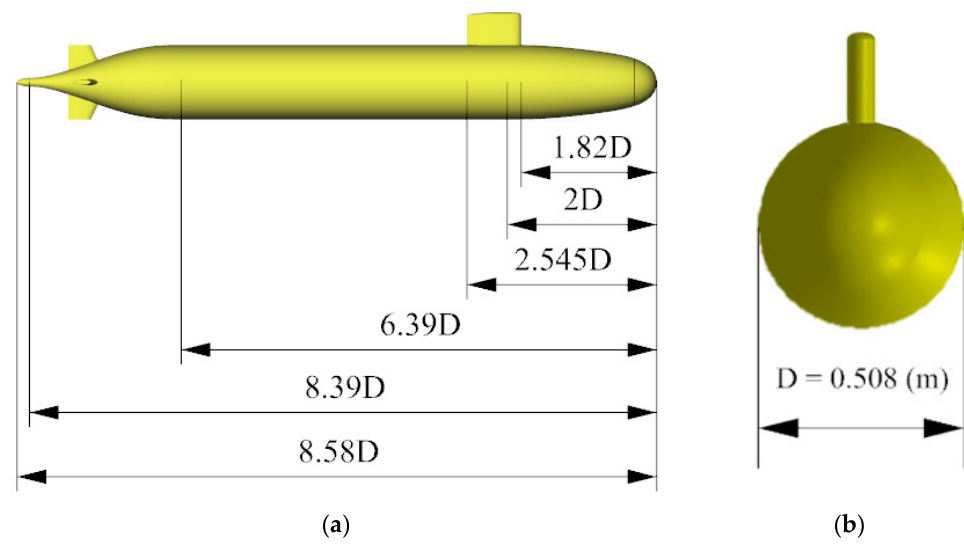
Figure 1. Schematic diagrams of SUBOFF model with full appendages at ( a ) side view, and ( b ) front view.